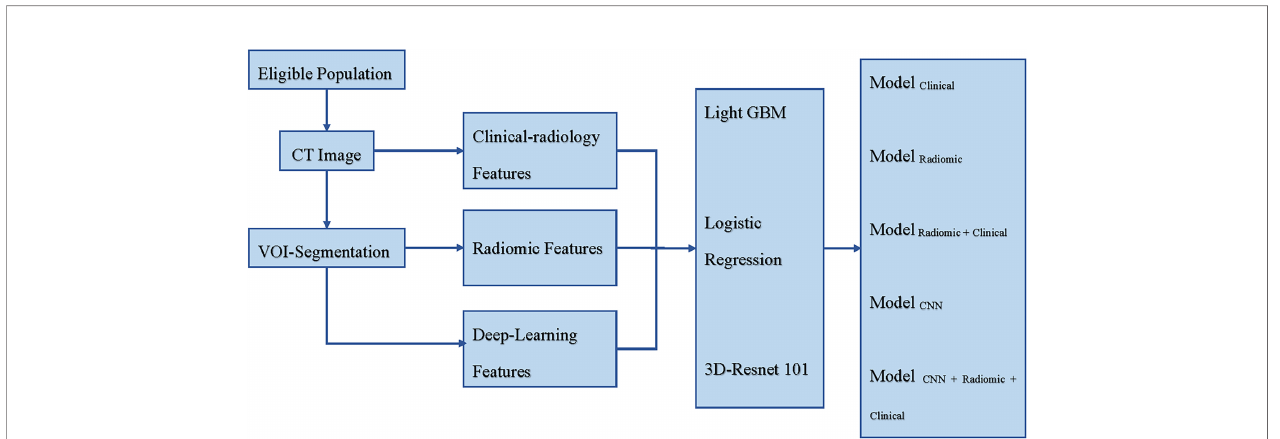
FIGURE 1 | Schematic for the models ’ construction. CT, Computed Tomography; VOI, Volume Region of Interest; Light GBM, Light Gradient Boosting Machine; Res-Net, Residual Network; Modelclinical incorporated clinical-radiology features, Modelradiomic incorporated radiomic features, Modelradiomic+clinical combined clinical-radiology and radiomic features, ModelCNN incorporated deep learning features, and ModelCNN+radiomic+clinical combined clinical-radiology, radiomic, and deep learning